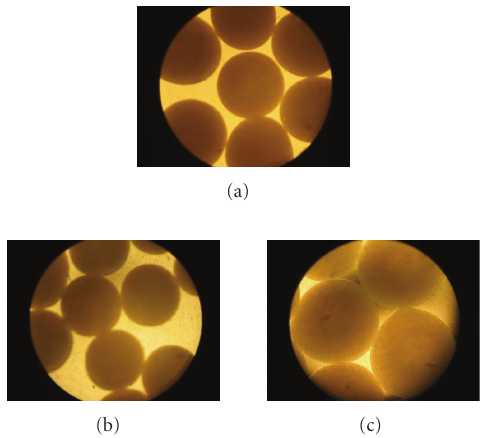
Figure 5: Evaluation of microcapsule integrity and morphological changes during simulated GI transit. (a) Pre-stomach transit (b) Post-stomach transit (60 minutes) (c) Post-stomach (60 minutes) and intestinal (10 hours) transit. Microcapsule size (a) 608 ± 36 µ m (b) 544 ± 40 µ m (c) 725 ± 55 µ